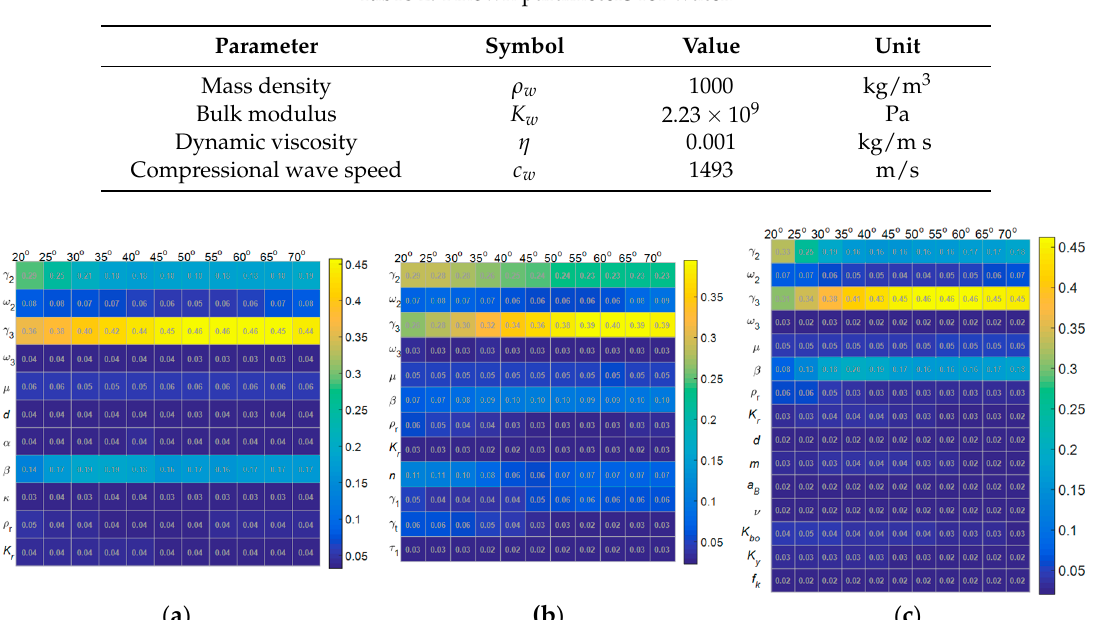
Figure 1. Borgonovo indices for: ( a ) fluid model; ( b ) grain-shearing elastic model; ( c ) poroelastic model.